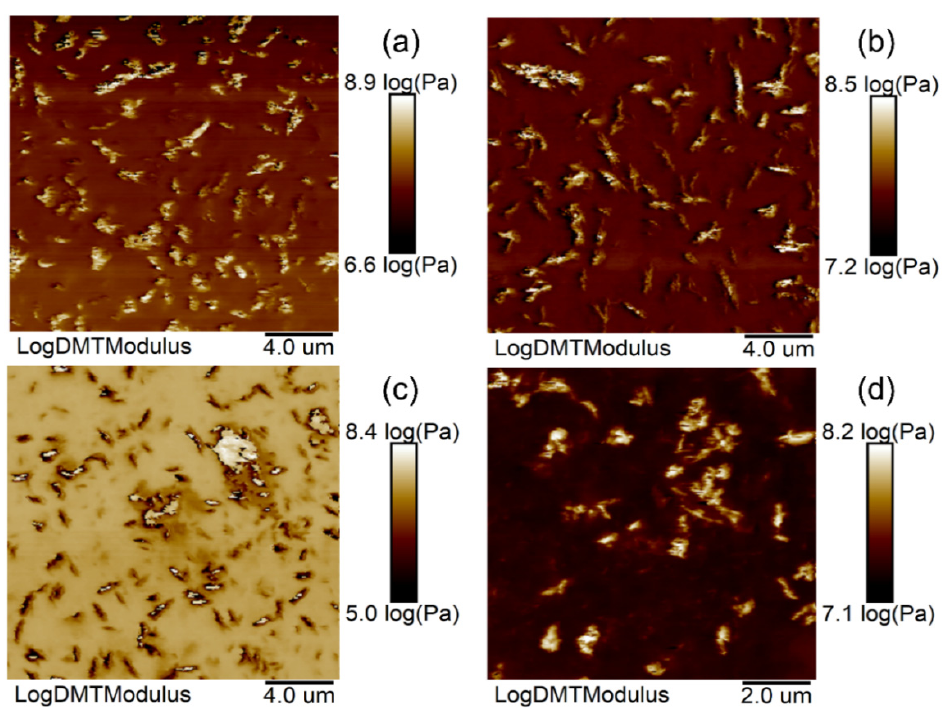
Figure 12. Atomic force microscope logarithmic modulus map of TPU composite doped with different amounts of MXene and CNTs: ( a ) 0.1 wt% MXene/0.2 wt% CNTs, ( b ) 0.25 wt% MXene/0.4 wt% CNTs, ( c ) 0.5 wt% MXene/0.6 wt% CNTs, (d) 1 wt% MXene/0.8 wt% CNTs.